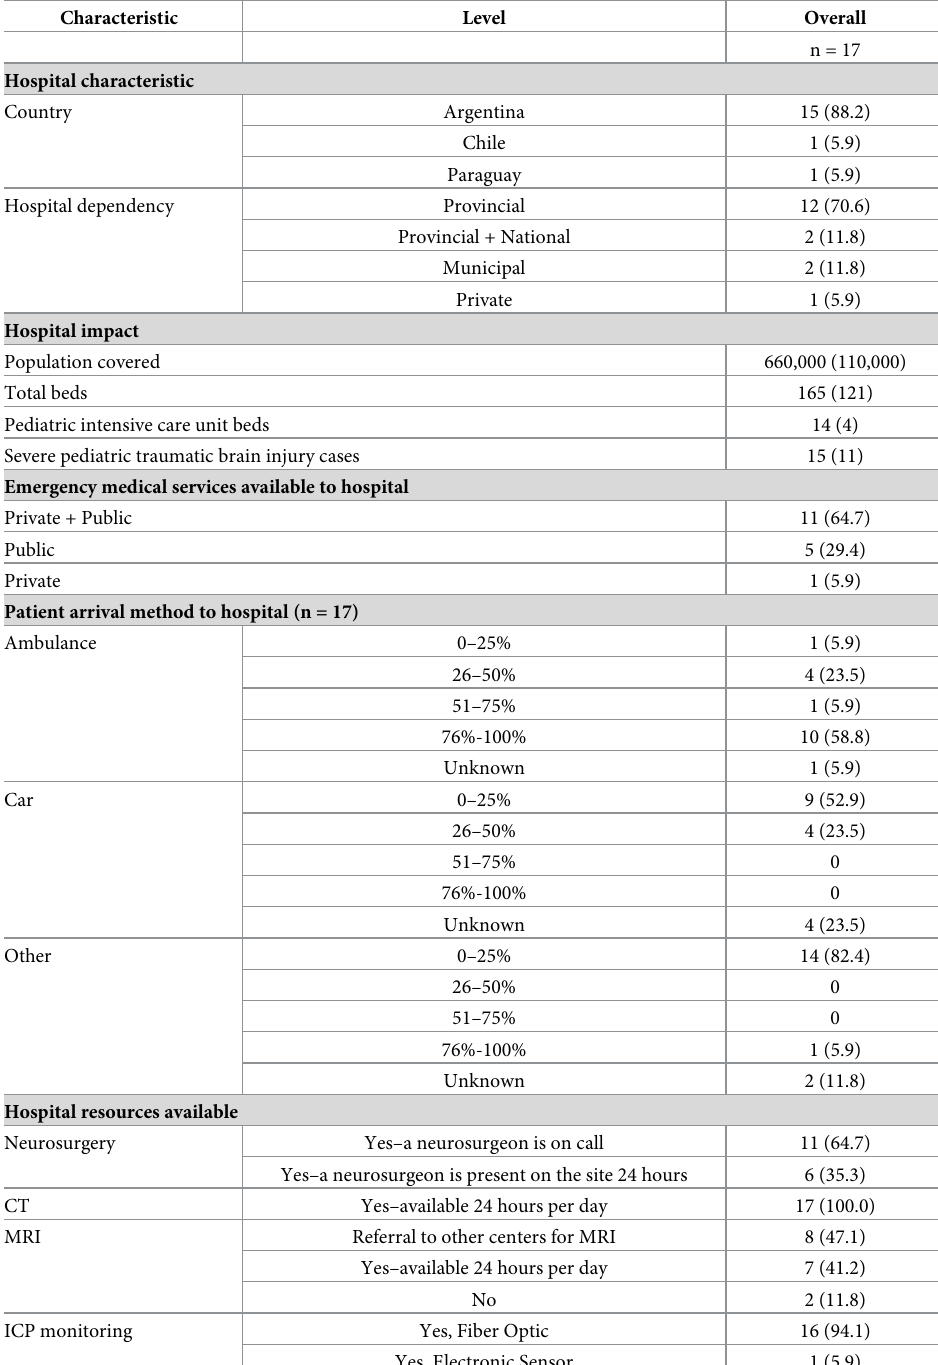
Table 1. Hospital characteristics for the 17 participating hospitals in South